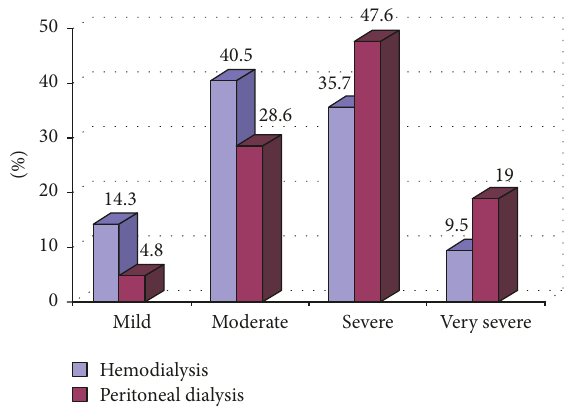
Figure 1: Percentage distribution of patients with restless legs syndrome in terms of their severity, according to the dialysis modality ( 𝑁 =